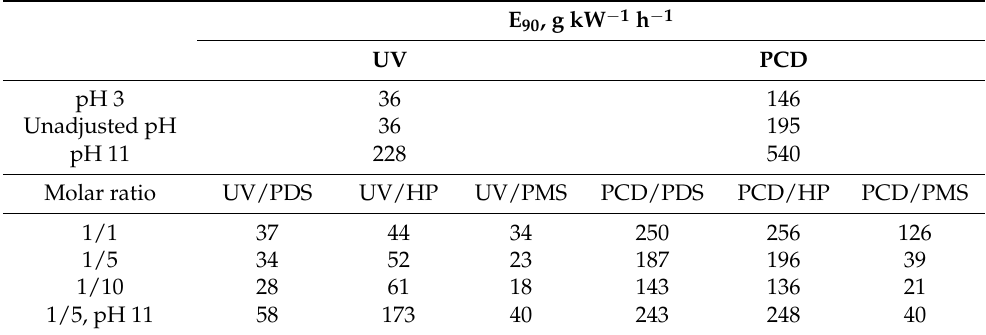
Table 2. Energy efficiencies of VMN oxidation in UV/oxidant and PCD/oxidant combinations ([VMN] 0 = 13.5 µ M, unadjusted